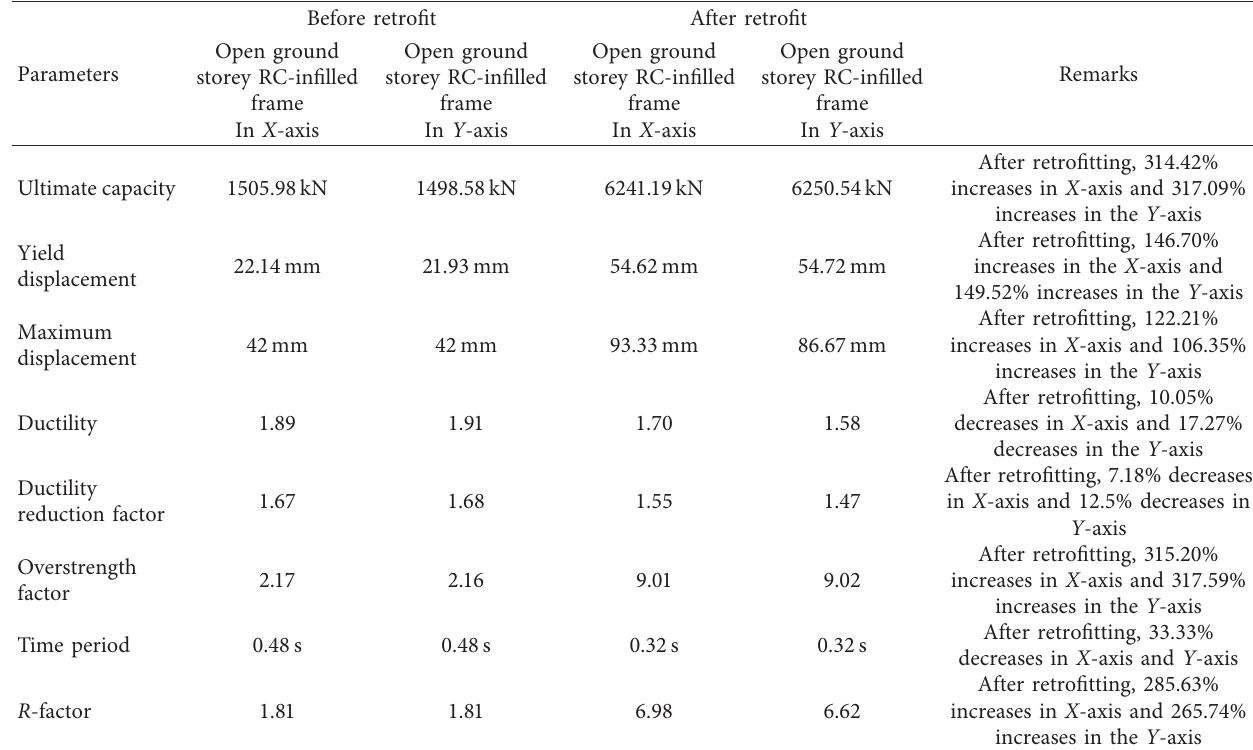
Table 6: Comparison of different parameters for the open ground storey RC-infilled